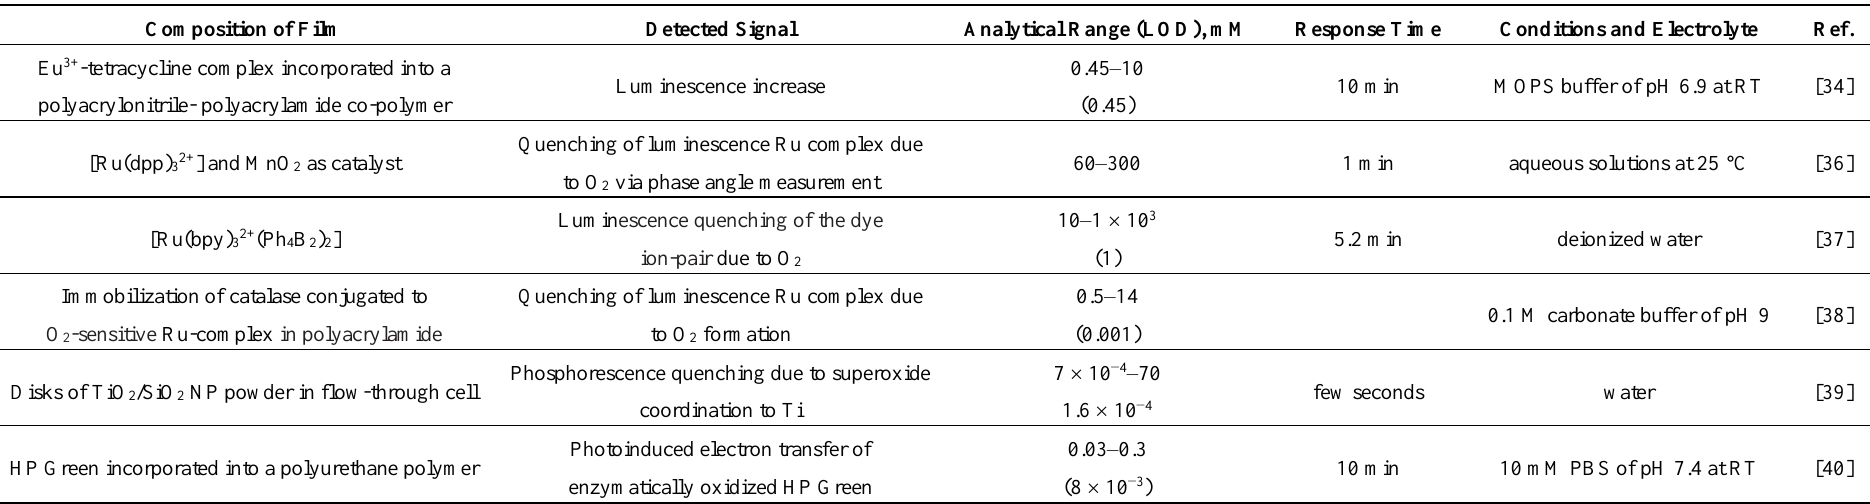
Table 2. Optical Sensor Films for Hydrogen